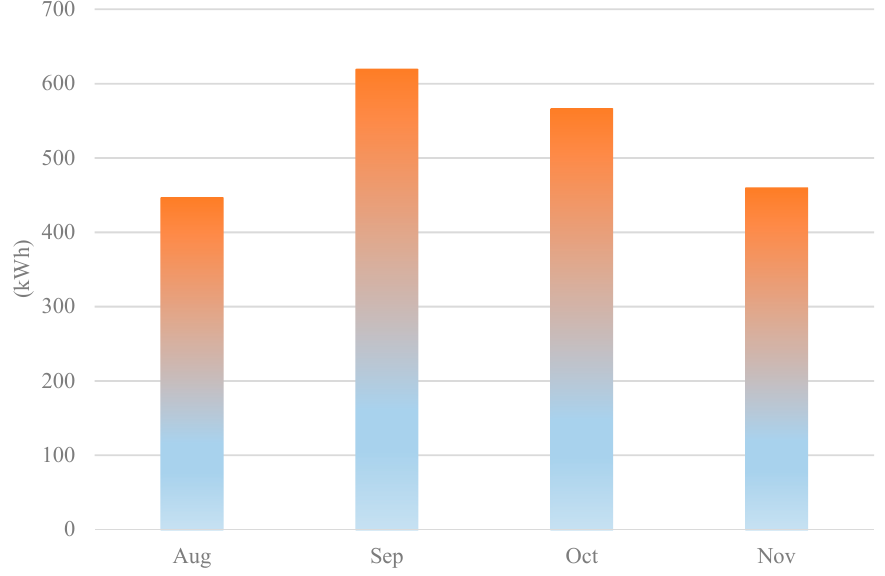
Figure 14. Surplus energy supplied by the PV system to the grid.